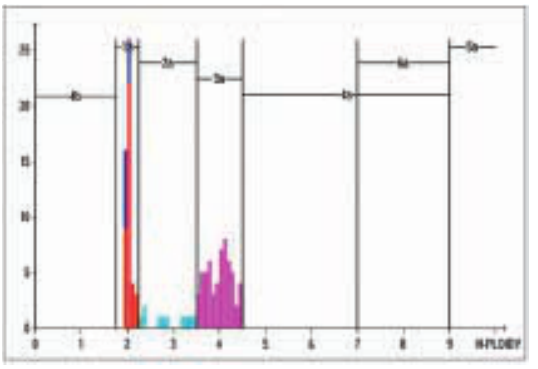
Figure 4 DNA histogram of pericardial effusion of a patient with proven viral peri- carditis (echovirus type IV) revealing the typical DNA profile of a highly proliferating cell population and nuclear inclusion of viral DNA respec- tively. Abcissa: DNA values in c-units; ordinate: number of measured nuclei. DNA mean value 3.2 (normal 2.0), DNA index 1.6 (normal 1.0), 2c deviation index 2.32 (normal 0), 5c exceeding events 0 (normal 0), 9c exceeding events 0 (normal 0). 91.5% of the measured